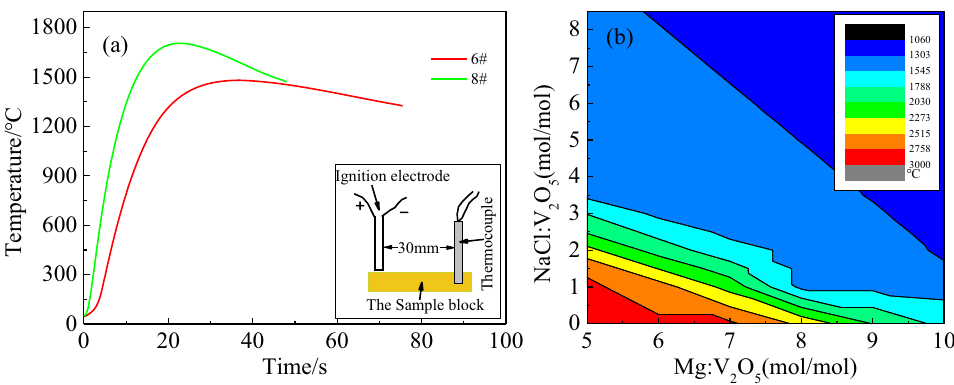
Figure 9: ( a ) Time – temperature curve of 6# and 8# samples. ( b ) The adiabatic temperature of di ff erent Mg and NaCl